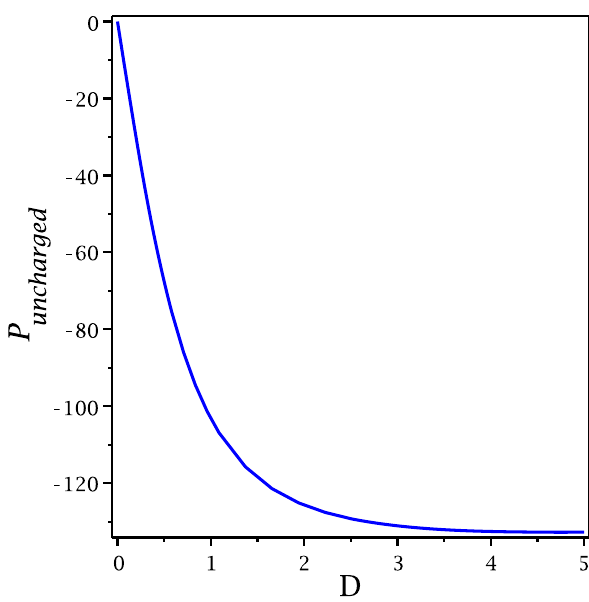
Fig. 11 The line pressure P uncharged vs radius D . We have chosen m 0 = − 80, H 0 = 70, A = 1, (cid:8)(ε) = − 1, and H (ε) = 1 . 1